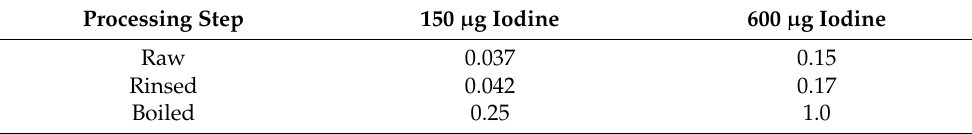
Table 2. Amount (in g dry weight) of S. latissima providing 150 and 600 µ g